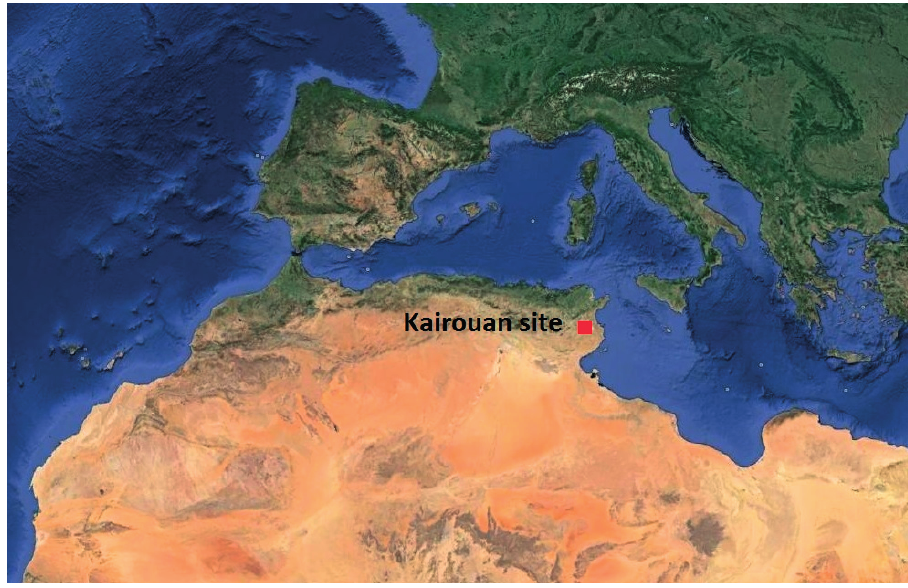
Figure 1. Location of the study